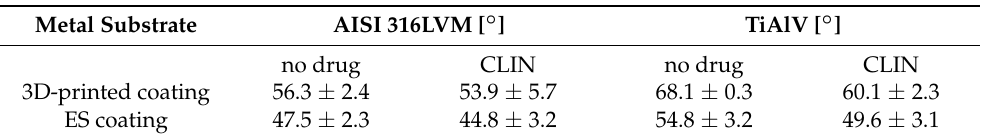
Table 2. Contact angles for the ES and the 3D-printed coatings with and without CLIN on AISI 316LVM and TiAlV. The results are given as average values ± standard deviation for the replicate measurements.